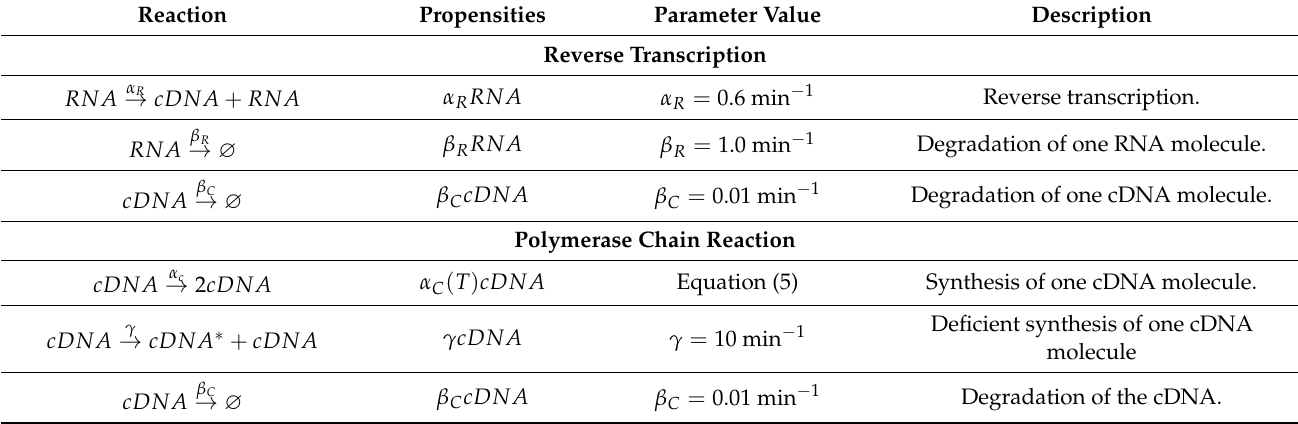
Table 1. Reactions, propensities and parameter values for the stochastic